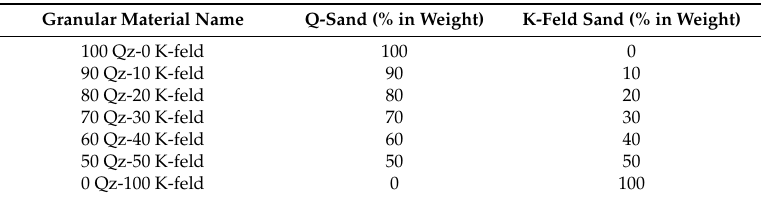
Table 1. Granular analogue materials tested in this study.